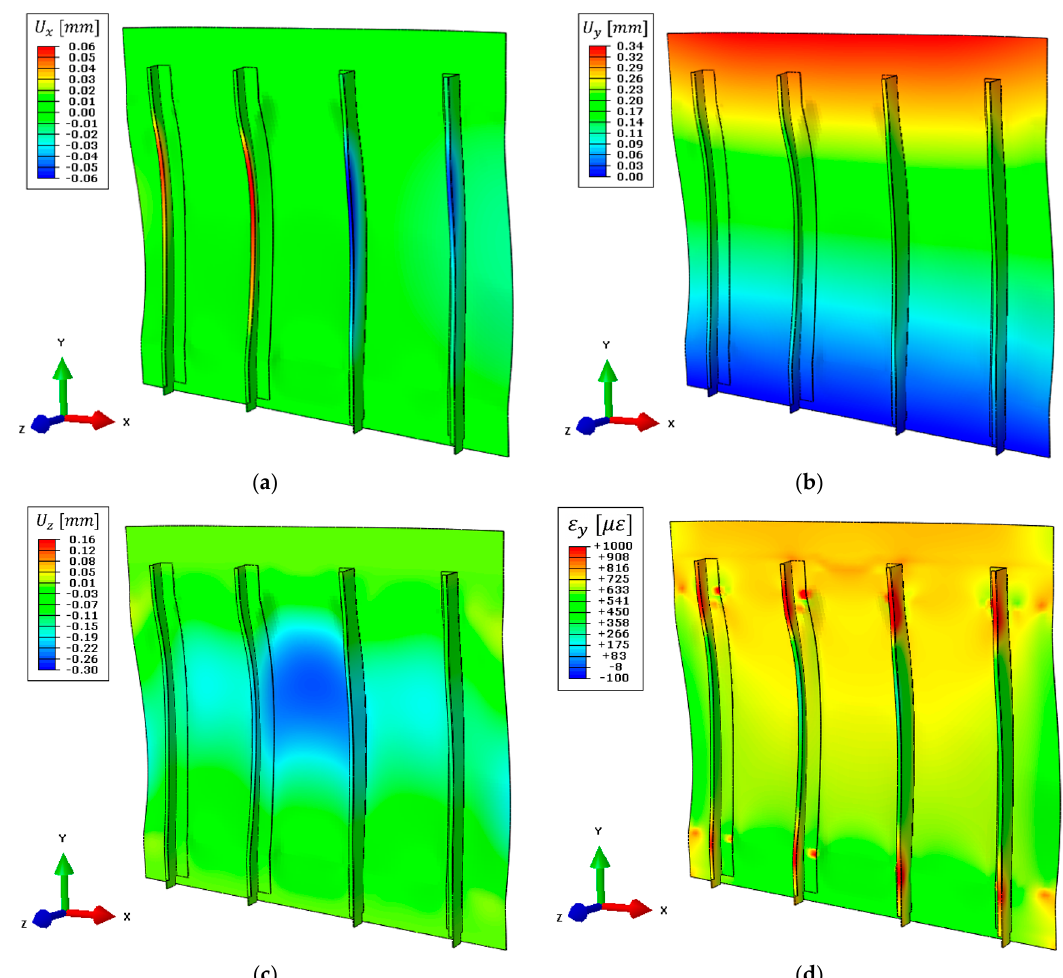
Figure 12. Simplified iFEM model results with experimental sensor network and numerically simulated input strain field, deformed shape with scale factor 100: ( a ) Displacement field on the x-direction, ( b ) displacement field on the y-direction, ( c ) displacement field on the z-direction, ( d ) strain field on the y-direction on the top side of the structure.